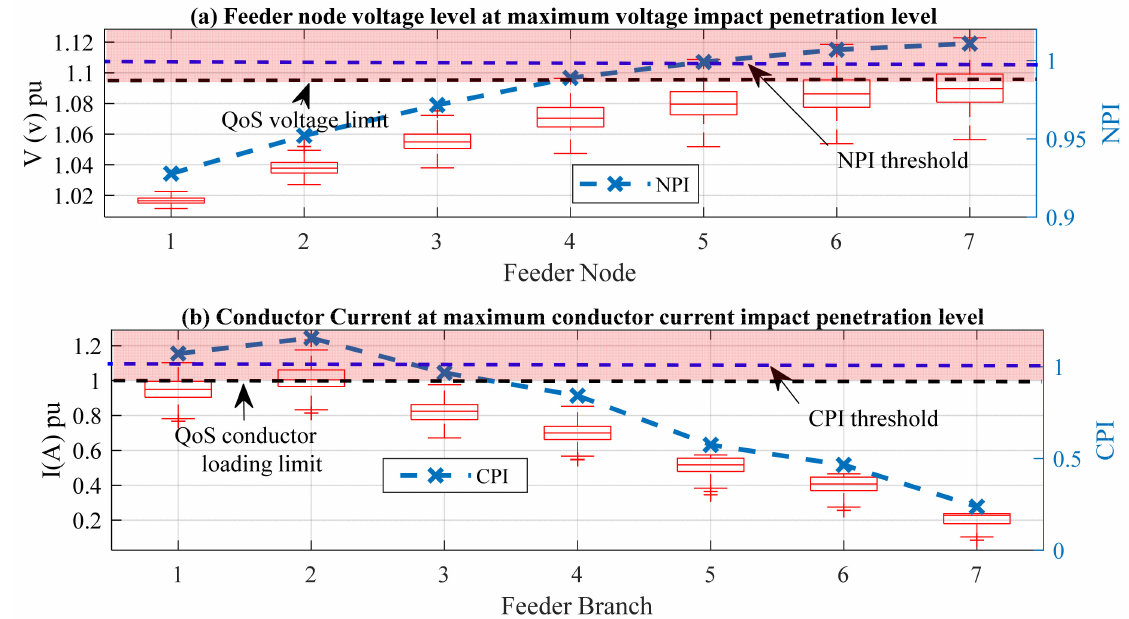
Figure 8. Illustrating the feeder node voltage level and feeder conductor loading performance and the respective perfor- mance indices (NPI, CPI) used in the resizing